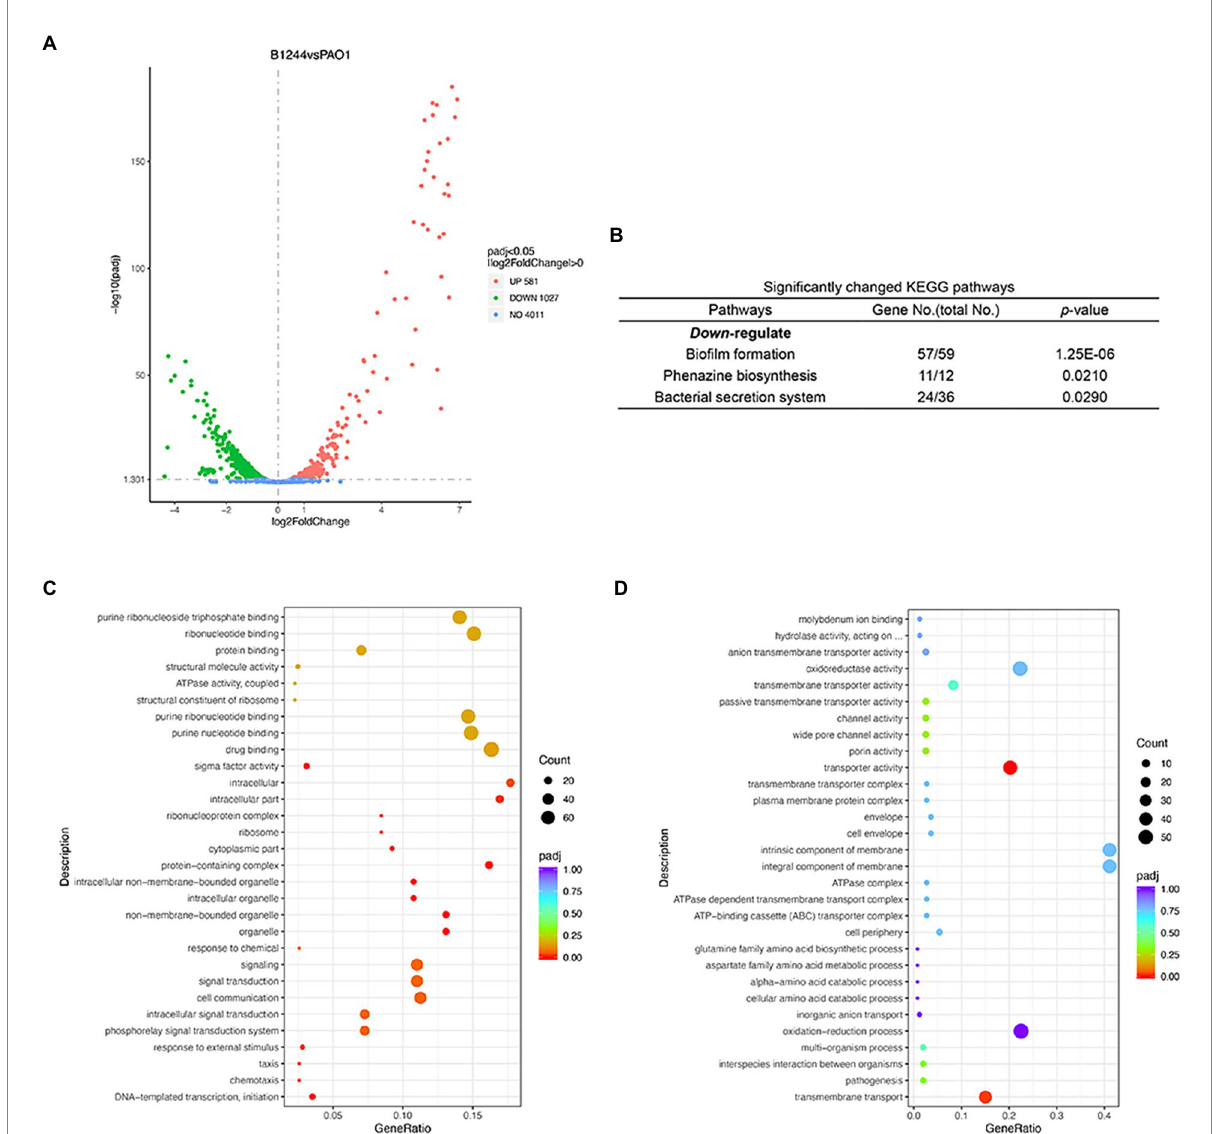
FIGURE 4 Effects of Dimetridazole on the transcriptome of Pseudomonas aeruginosa PAO1. (A) Number of significantly differentially expressed genes of P. aeruginosa PAO1 influenced by 200 μ M of Dimetridazole. (B) Significantly changed KEGG terms influenced by 200 μ M of Dimetridazole. Significantly (C) downregulated and (D) upregulated GO terms caused by 200 μ M of